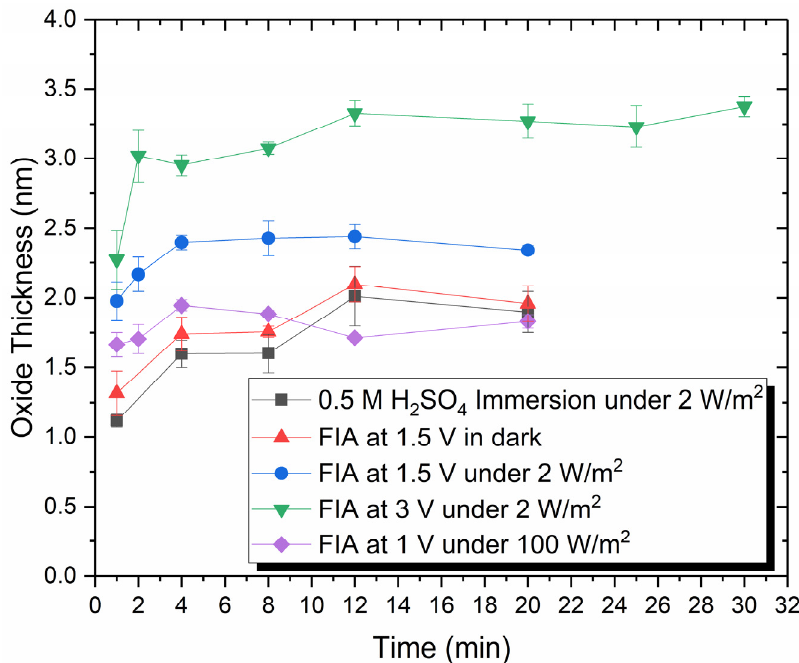
Figure 2. Thickness of the SiO x layer formed by immersion in 0.5 M H 2 SO 4 and FIA under different anodisation conditions. The thickness was measured using ellipsometry at 5 different points across the wafer and is represented as a mean with the error bars representing the standard deviation [28].